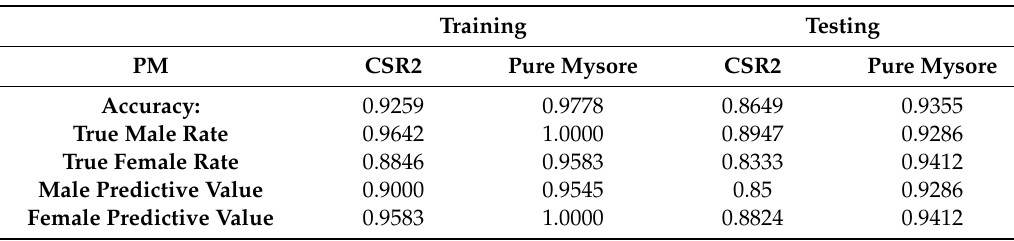
Table 5. Performance metrics (PM) obtained for CSR2 and pure Mysore cocoons from SVM training and